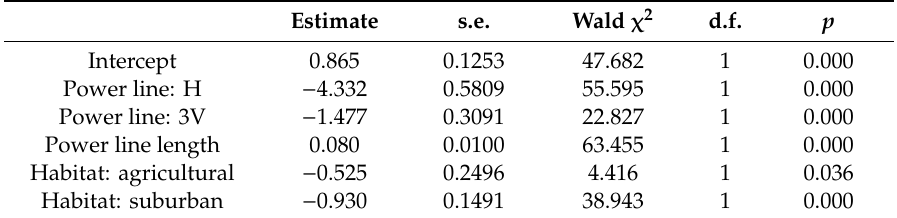
Table 2. Results of the generalized linear model for assessing variability in electrocution rates of flying foxes. Explained deviance: